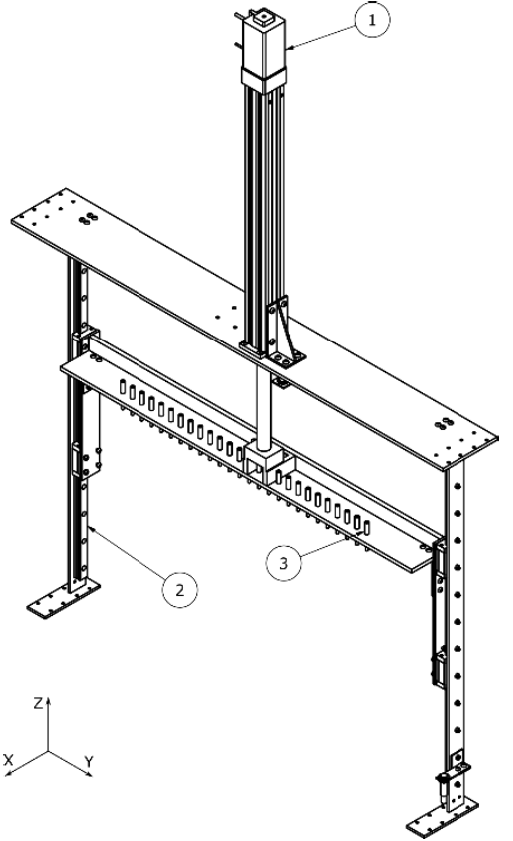
Figure 6. Z-DOF. 1-Linear Actuator SMC LEY32DB-450BF-R5CP18 [12]; 2-Linear Bearing Guide MISUMI SX2RL28 [14]; 3-Metallic Electrodes. The Y -axis moves the ultrasonic sensors and is implemented by a short linear electric actuator SMC LES16RJ-75S-R5CP18 [14] and its symmetric SMC LES16LJ-75S-R5CP18 [18]. They have a short motion range and can achieve a positioning precision of 0.05 mm, being ideal for making the ultrasonic transducers contact with the block and back away to avoid damage without interfering with the system. Finally, four inductive digital limit sensors, Telemecanique XS612B2PAL01M12 [16], are used to perform the home and to limit the linear actuators X and Z. Figure 7 shows a detailed view of the Y-DOF.